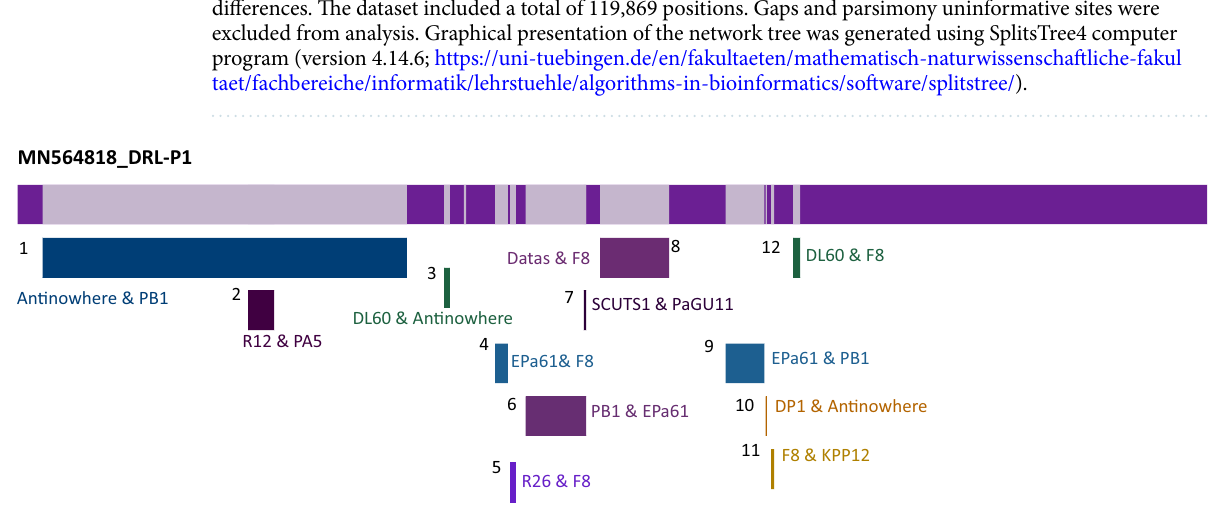
Figure 9. Recombination map showing 12 recombination events in the DRL-P1 genome, as detected by the RDP4 computer program. The dataset included DRL-P1 and 37 NCBI-RefSeq complete genome sequences. Details of the recombination events are presented in Table 2. Minor and Major parent involved in each of the recombination event is indicated by the most similar RefSeq isolate name. Graphical presentation of the recombination events was generated using the RDP4 computer program (version 4.95; http:// web. cbio. uct. ac. za/ ~darren/ rdp.